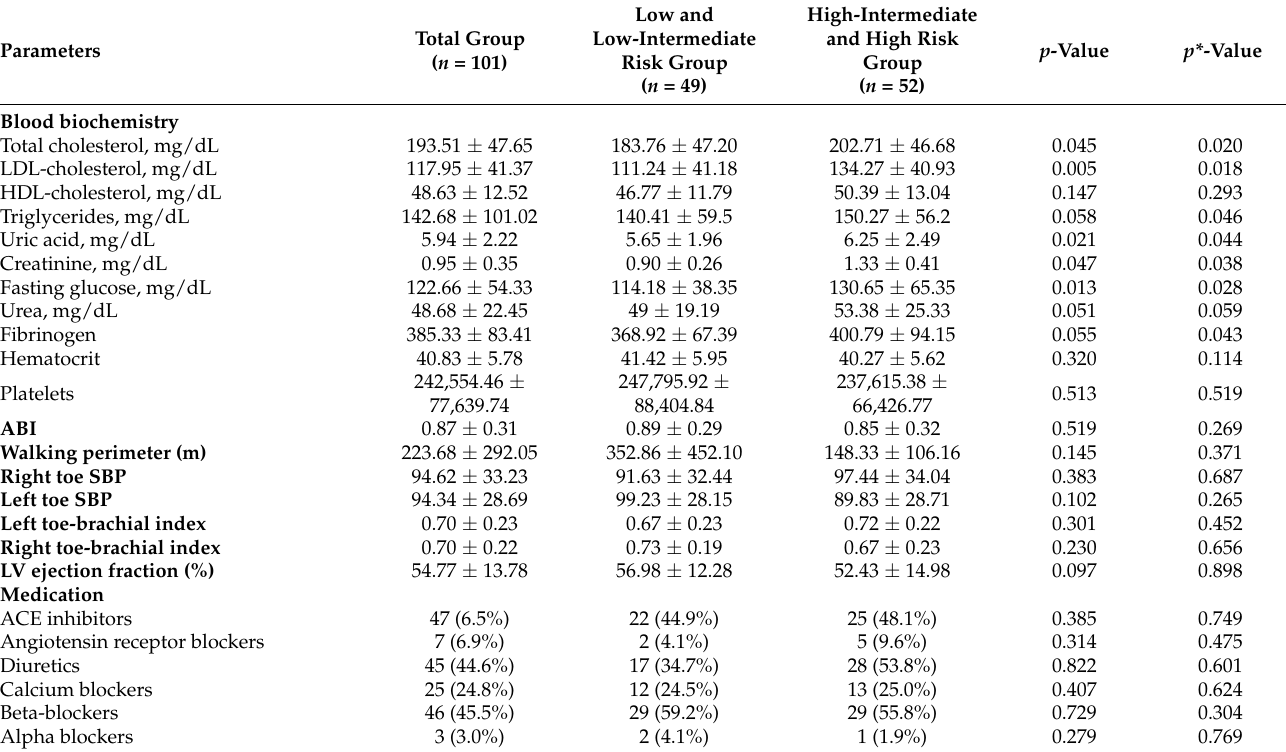
Table 2. Risk factors included in the prognostic